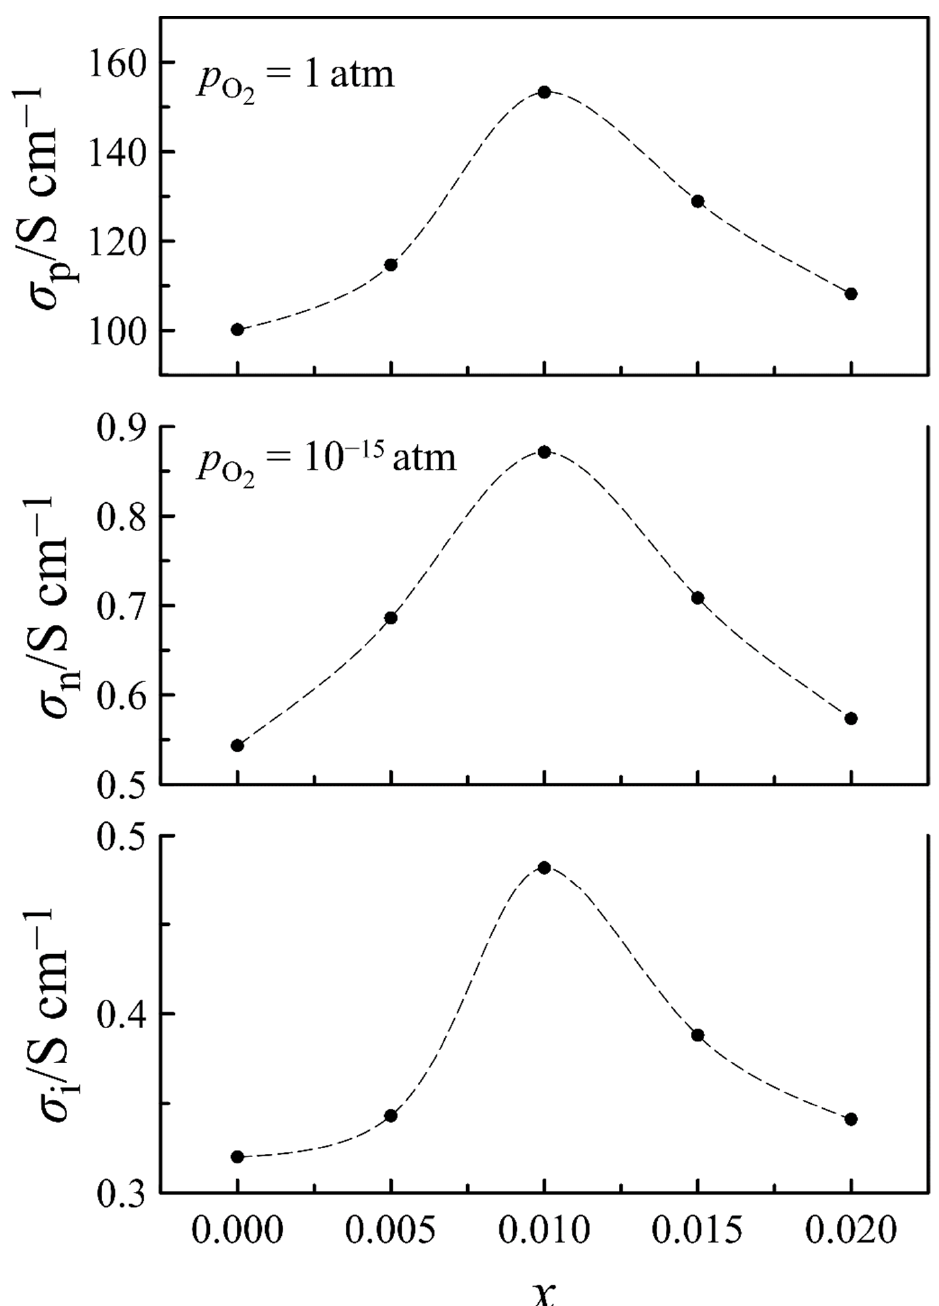
Figure 8. Partial contributions to the conductivity of La 0.5 − x Sr 0.5 FeO 3 − δ as functions of cation deficiency. Dashed lines are guides for the eyes.